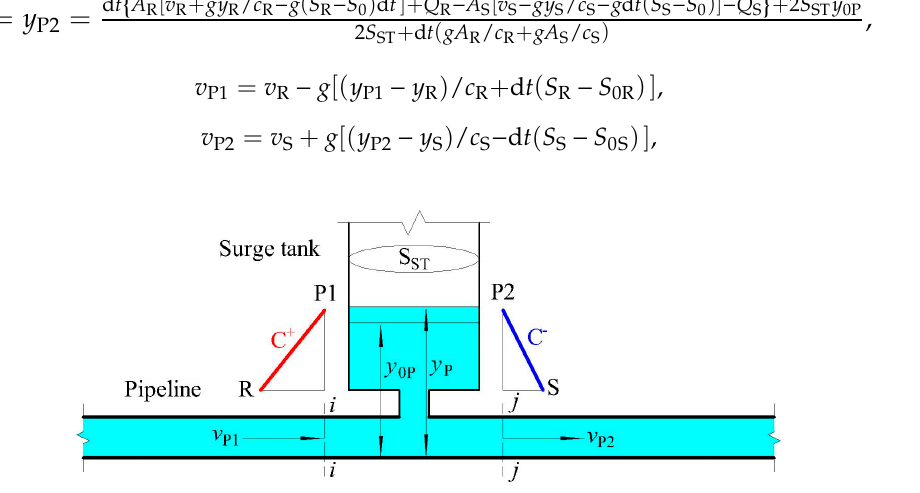
Figure 8. Logical boundary condition of a surge tank.